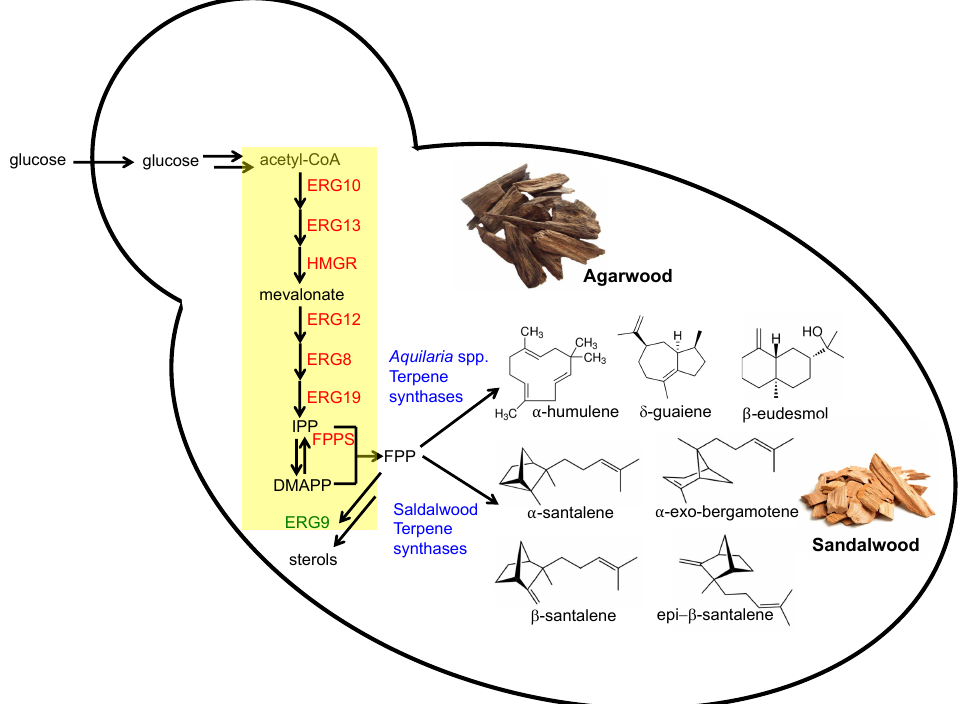
Figure 1. Metabolic engineering of S. cerevisiae for production of fragrant terpenoids from agarwood and sandalwood. Mevalonate pathway enzymes (yellow box, highlighted in red) were overexpressed to increase the pool of the key intermediate farnesyl pyrophosphate (FPP). Terpene synthase enzymes (highlighted in blue) were heterologously expressed in the engineered yeast to produce the fragrant terpenoids. Expression of the squalene synthase enzyme ERG9 was repressed to minimize the diversion of FPP towards sterol biosynthesis. ERG10, Acetyl-CoA C-acetyltransferase (acetoacetyl-CoA thiolase); ERG13, 3-hydroxy-3-methylglutaryl-CoA (HMG-CoA) synthase; HMGR, HMG-CoA reductase; ERG12, Mevalonate kinase; ERG8, Phosphomevalonate kinase; ERG19, Mevalonate pyrophosphate decarboxylase; FPPS, farnesyl pyrophosphate synthetase (synthase); ERG9, squalene synthase.